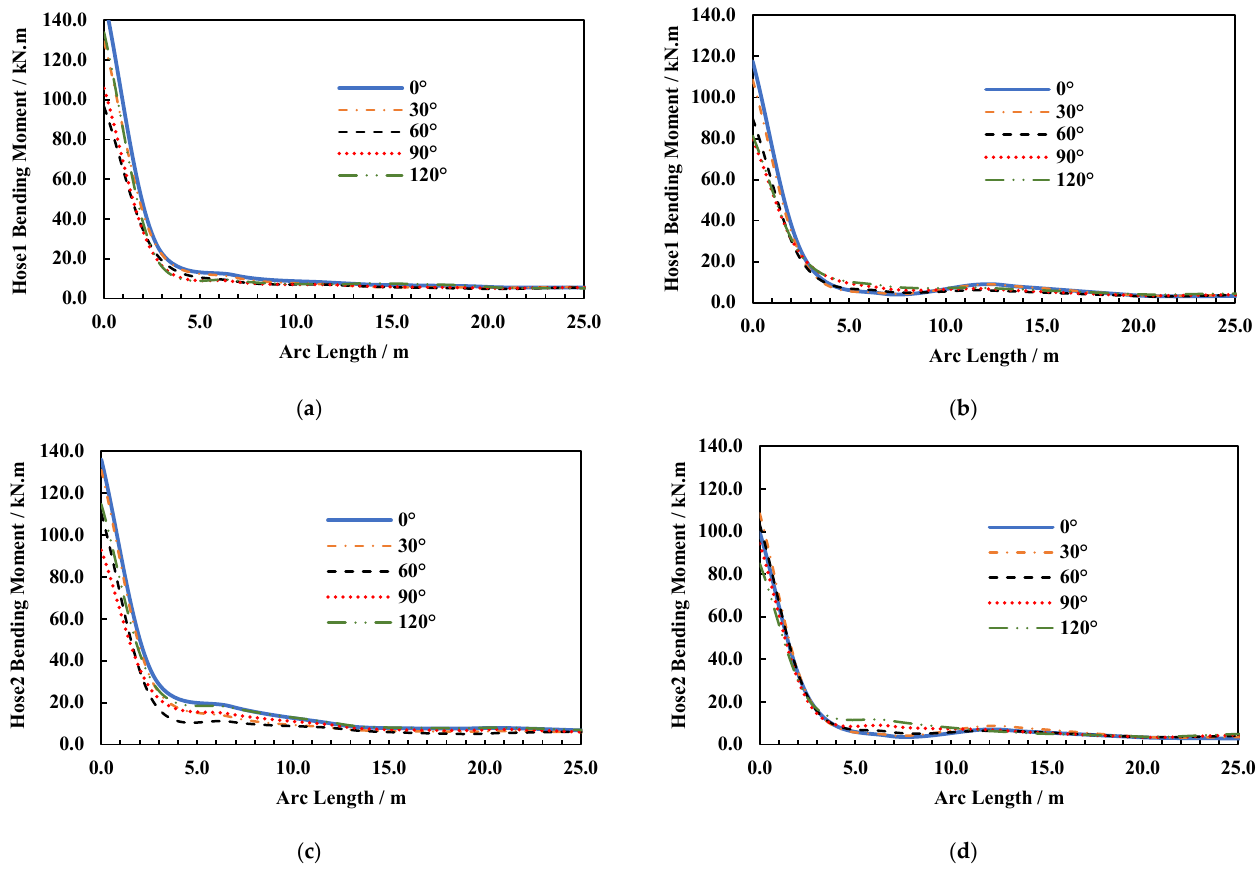
Figure 25. Influence of RAOs on bending moments for different wave directions. Figures ( a , c ) are when the hoses have RAO loads, while Figures ( b , d ) are when the hoses are without RAO loads for the submarine hoses in Lazy-S config. ( a ) Hose1 Bending Moment including hose hydrodynamic load. ( b ) Hose1 Bending Moment excluding hose hydrodynamic load. ( c ) Hose2 Bending Moment including hose hydrodynamic load. ( d ) Hose2 Bending Moment excluding hose hydrodynamic load.